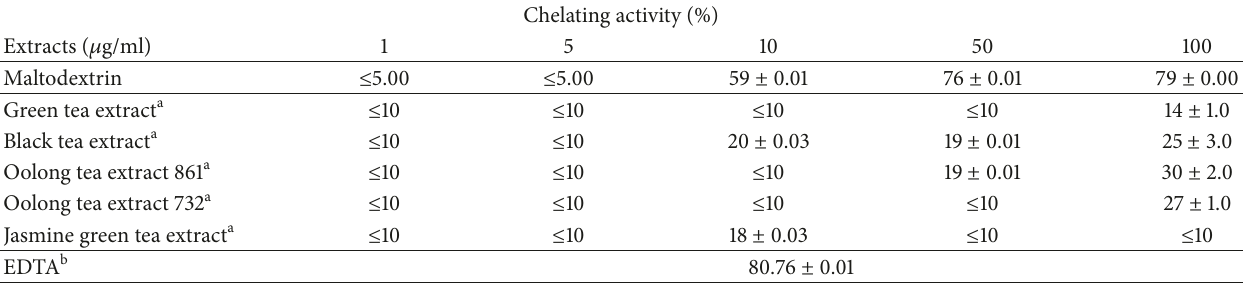
Table 2: Five different concentrations with chelating activity of five tea extracts.